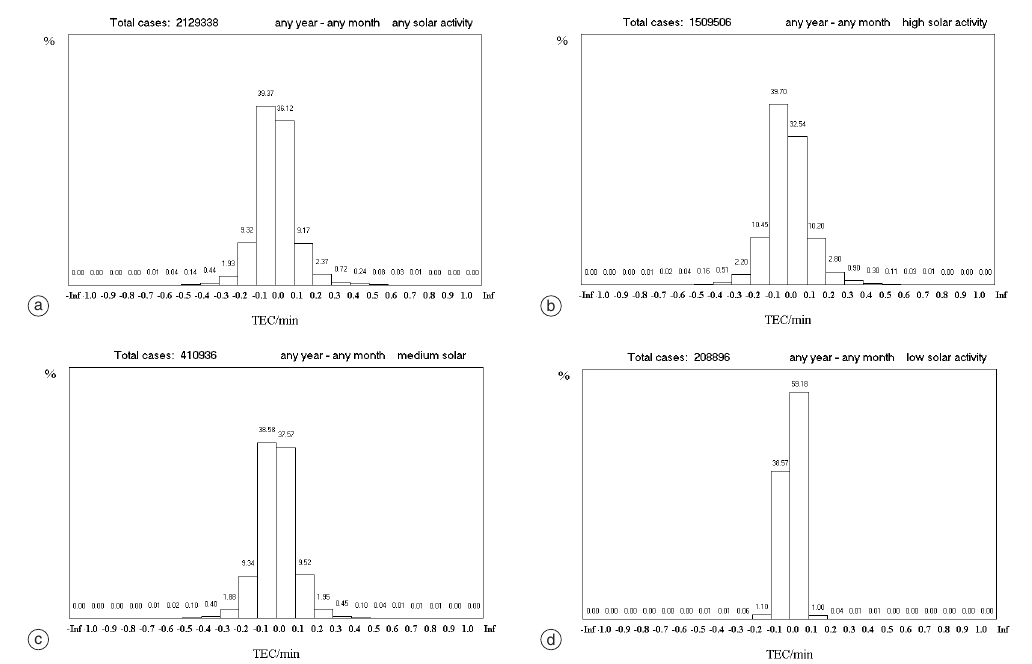
Fig. 9.4a-d. Distribution of the time derivative of